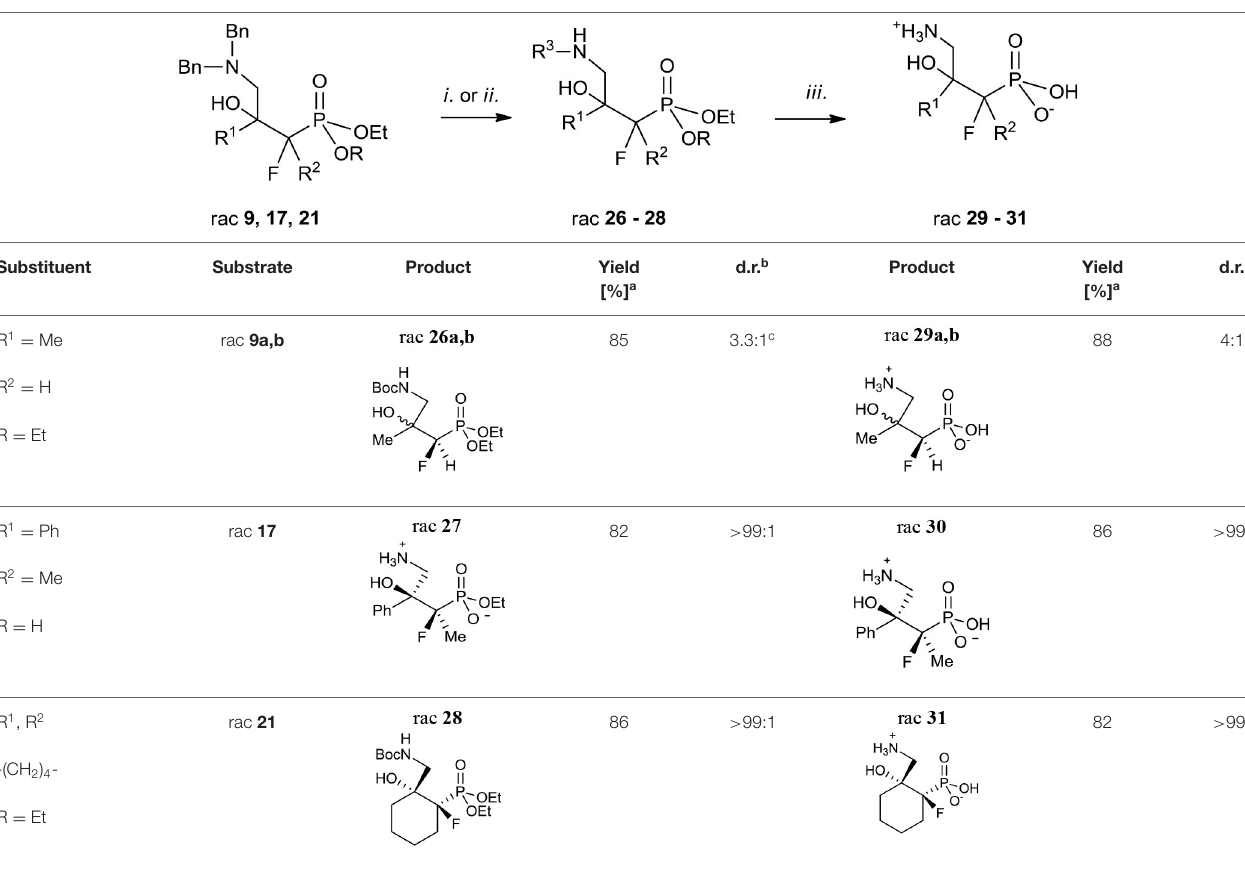
TABLE 5 | Synthesis of fluorinated γ -amino- β -hydroxy alkylphosphonic acids 29–31 .